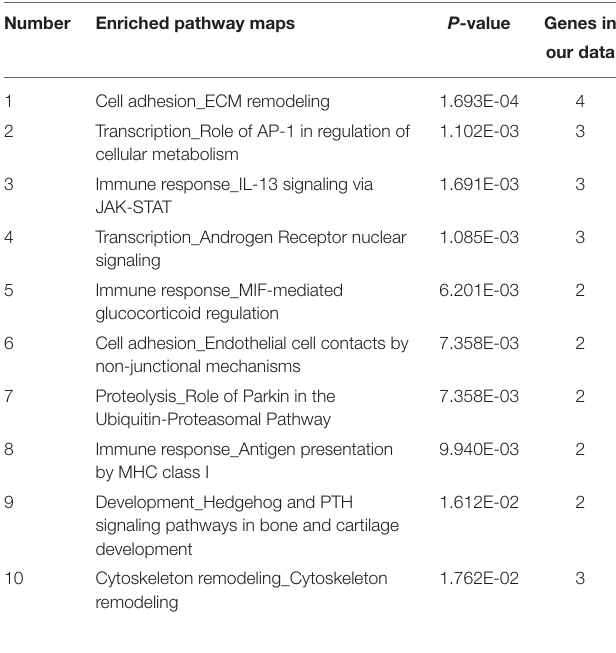
TABLE 3 | Top 10 pathway maps by MetaCore ® analysis in diabetic heart 5 days following DOX.